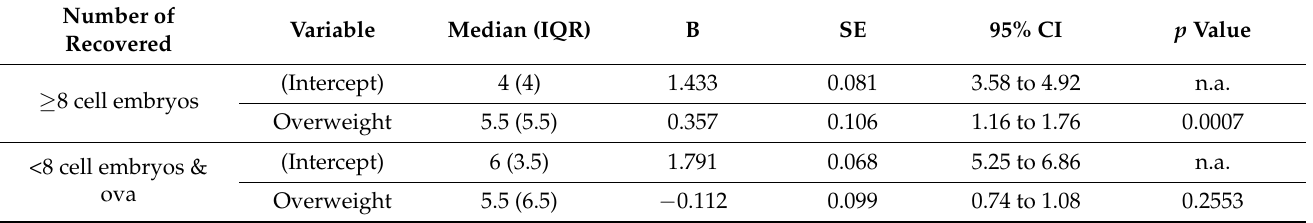
Table 4. Univariate Poisson regression for the number of recovered ≥ 8 cell embryos and for the number of recovered <8 cell embryos & ova on embryonic day 3 in fertilized female mice (i.e., mated and ovulating females with at least one embryo in the reproductive